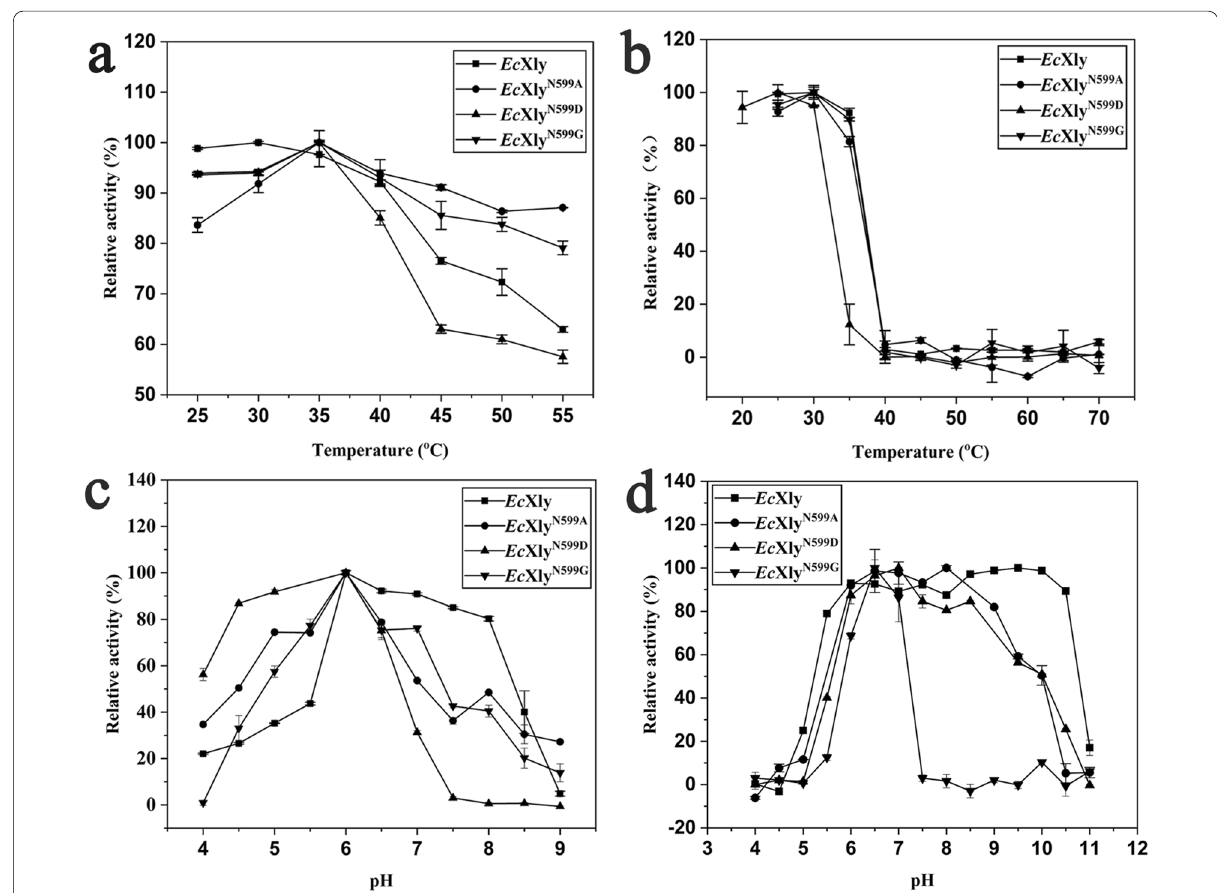
Fig. 5 Biochemical characteristics of Ec Xly and its mutants. a The optimum temperature, b thermal stability, c optimum pH and d pH stability